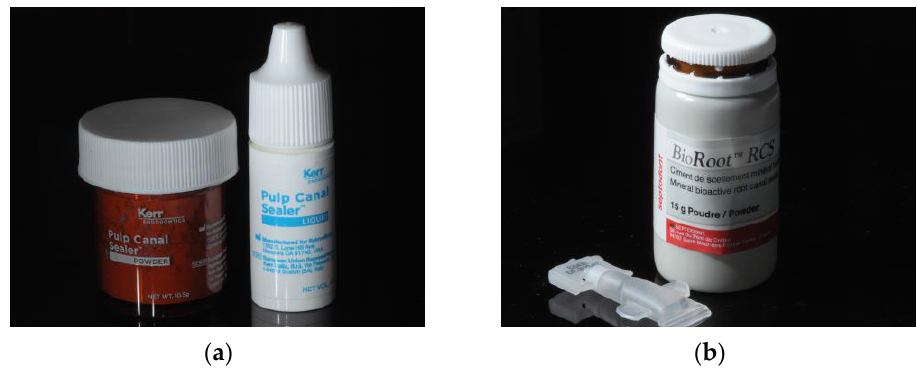
Figure 1. Root canal sealers investigated in the study: ( a ) zinc-oxide-eugenol-based canal sealer; ( b ) tricalcium-silicate-based sealer. Table 1. Information about the root canal sealers investigated in the study.